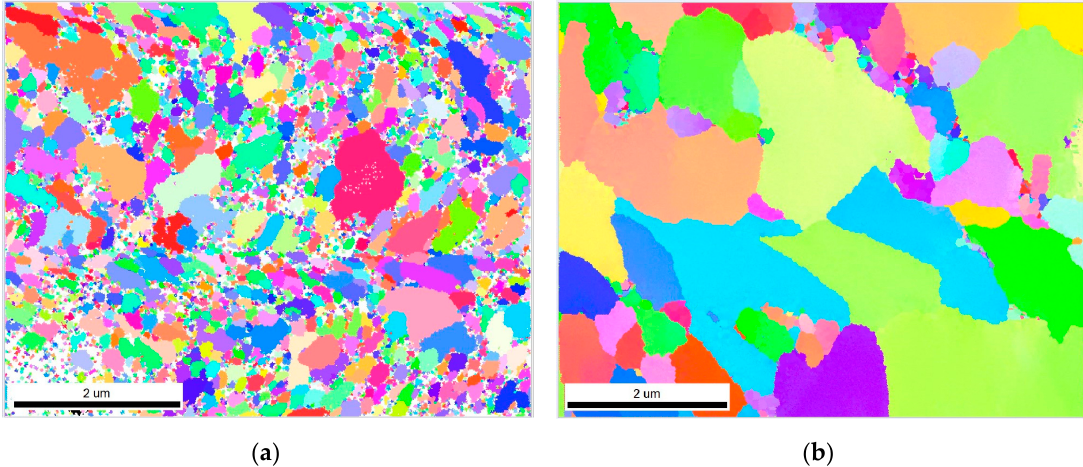
Figure 3. Electron backscattered diffraction (EBSD) inverse pole figures (IPF) of FAST consolidated Fe 91 -Ni 8 -Zr 1 samples processed at 750 ◦ C-30 min ( a ) and 750 ◦ C-60 min ( b ).